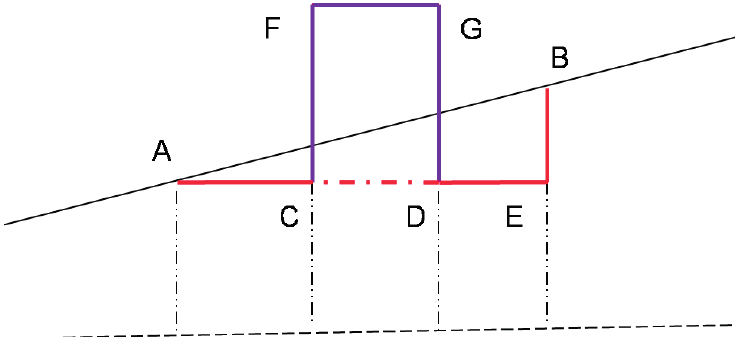
Figure 13. Cross-section of old and new DSMs, where the black solid line AB represents the cross-section of the old DSM, and the red and purple lines ACFGDEB represent the cross-section of the new DSM. The purple line CFGD represents the cross-section of the building. The red line ACDEB represents the cross-section of the new terrain.